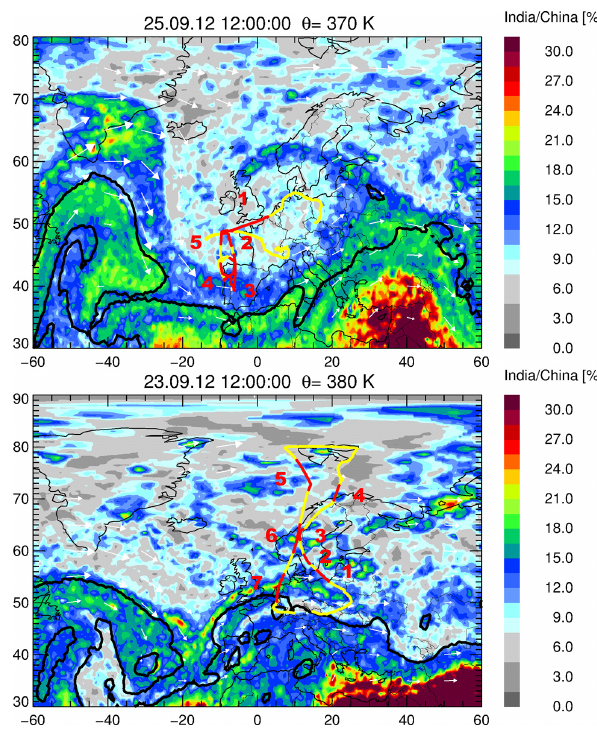
Figure 7. Horizontal (top) cross section of the fraction of air origi- nating in India/China over Europe on 26 September 2012. The flight path transferred to noontime of the TACTS/ESMVal flight is shown as a yellow line. Segments of the flight in the lower stratosphere with enhanced measured CO, CH 4 , and H 2 O, and reduced O 3 com- pared to the stratospheric background are highlighted in red and numbered for clarification (the same numbers are used in Fig. 9) The climatological isentropic transport barrier of 7.2PVU at 380K is shown as a thick black line. The thick white line marks the posi- tion of the vertical (bottom) cross section at 8 ◦ W longitude, which is similar to the cross sections shown in Figs. 5 and 6.